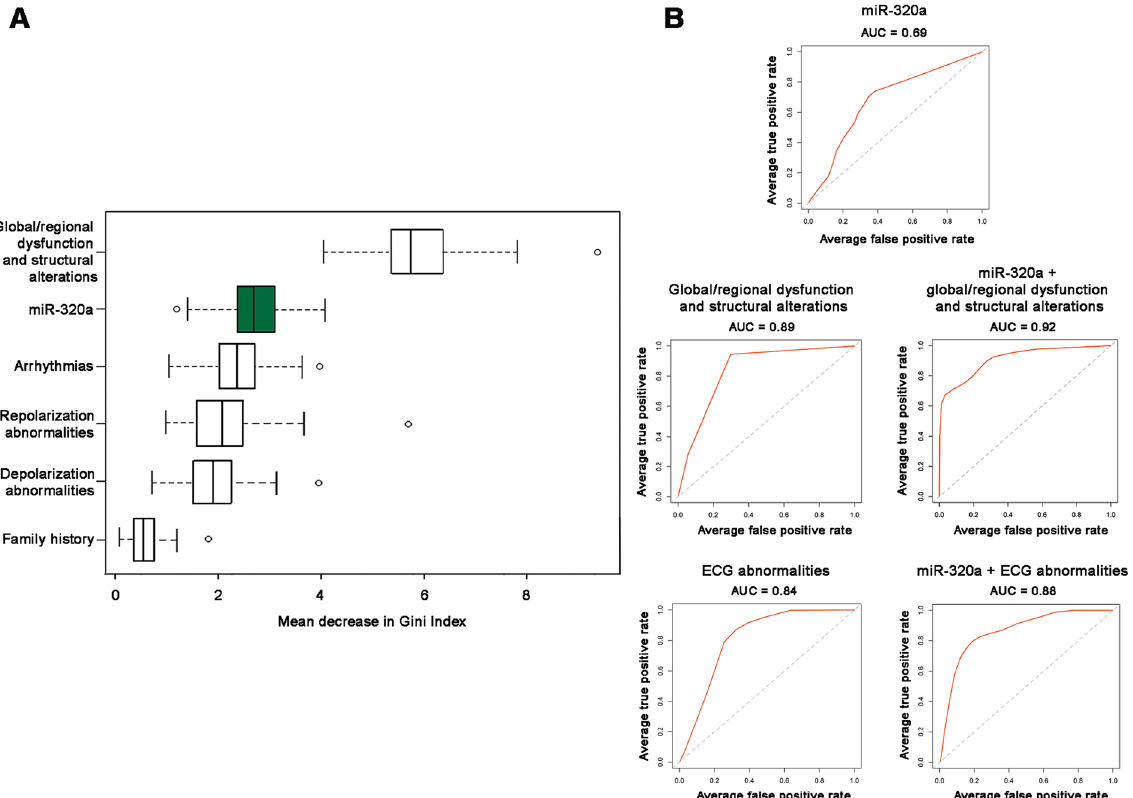
Figure 5. Importance of non-invasive ACM established diagnostic variables and miR-320a in Arrhythmogenic CardioMyopathy (ACM) vs. Idiopathic Ventricular Tachycardia (IVT) classification. ( A ) Boxplots show the distribution of mean decreases in Gini index for non-invasive ACM diagnostic criteria and miR-320a (green boxplot), ranked based on the importance in data partition as calculated by the Random Forests procedure. Data are shown as median[Q1–Q3]: global/regional dysfunction and structural alteration, 5.75[5.40–6.39]; miR-320a, 2.72[2.43–3.12]; arrhythmias, 2.45[2.10–2.79]; repolarization abnormalities,